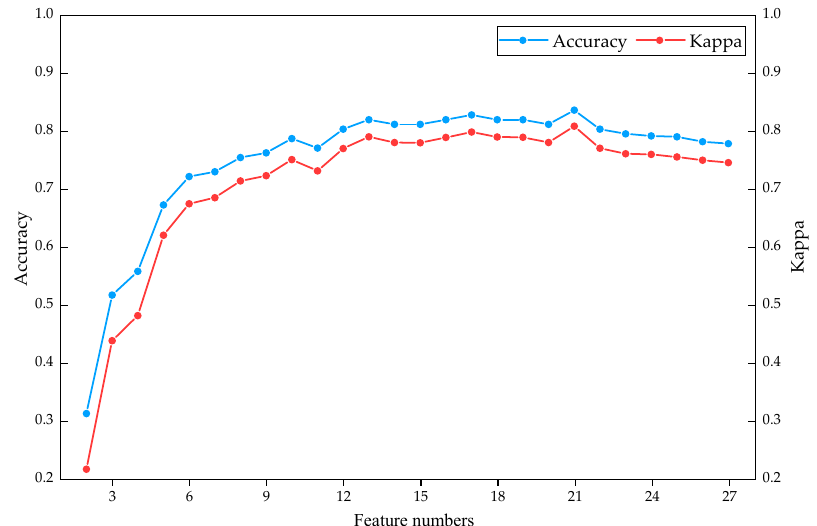
Figure 4. Relationship between the number of characteristic variables and classification accuracy and the kappa coefficient. The blue line represents the classification accuracy, whereas the red line corresponds to the kappa coefficient. Table 4. Results of experimental protocols.